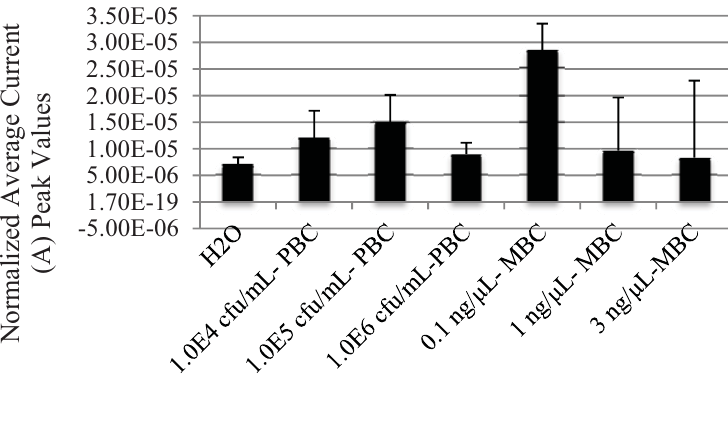
Figure 5. Non-PCR amplified S. enteritidis genomic DNAt can be detected in acidic liquid food matrices using the AuNP-DNA biosensor. Graphs represent the average differential current peak values vs. DNAt concentration attained from genomic DNAt extracted from O, blank control; NS-DNA, non-specific PCR PBC and MBC spiked orange juice. H 2 amplified B. anthracis DNAt (0.1 ng/μL) negative control; HCl, 1M hydrogen chloride. Graphs represent the average value of duplicate samples for each condition. Error bars represent the standard deviation of the